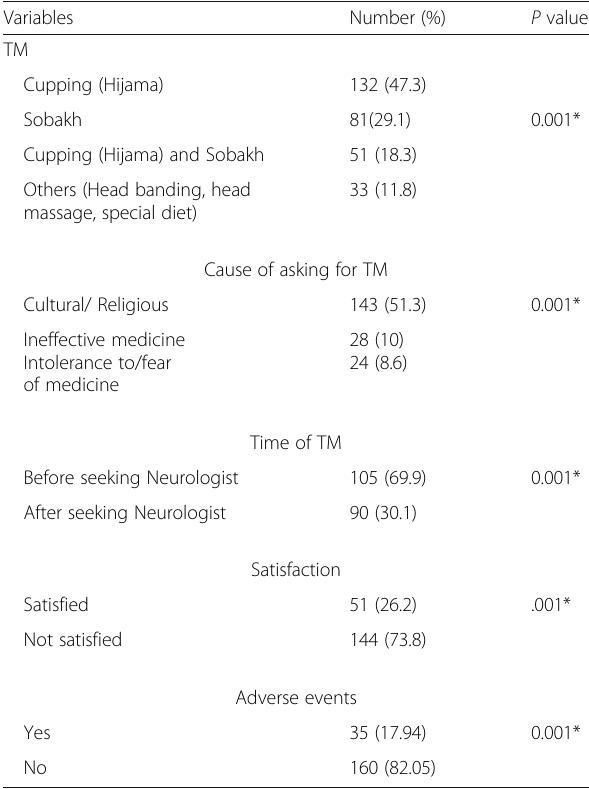
Table 2 Analysis of frequency, reasons and satisfaction of TM